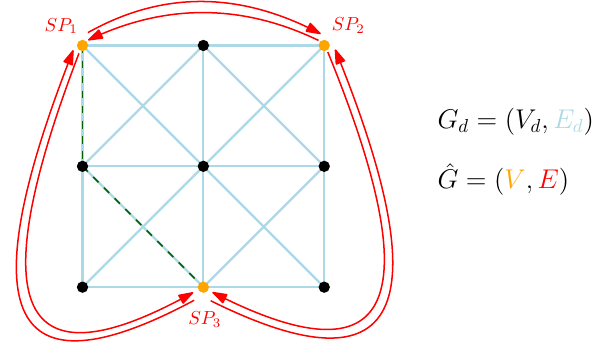
Figure 3. The underlying graphs: The weighted complete graph ˆ G consisting of optimally selected standpoints (orange vertices) is the basis for the TSP. The weights are induced building upon the graph G d on an octilinear grid. The weight w of the edge connecting SP 1 and SP 3 corresponds to the geometric distance on the octilinear grid (green dashed